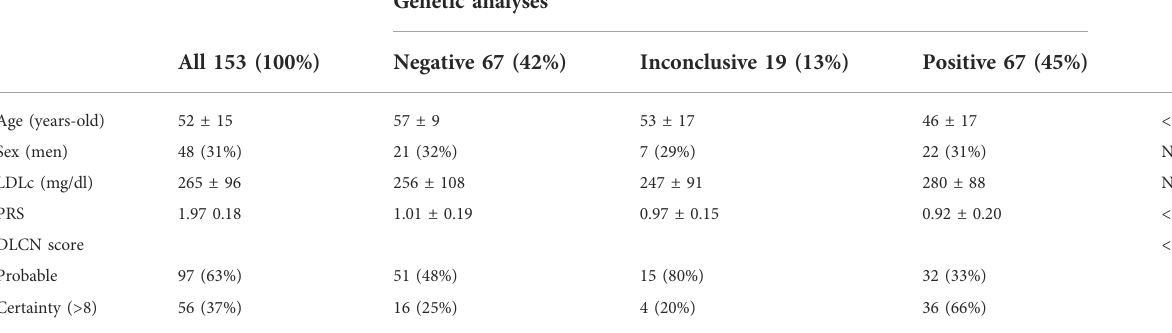
TABLE 1 Demographic and clinical data from patients genetically tested for Familial Hypercholesterolemia.